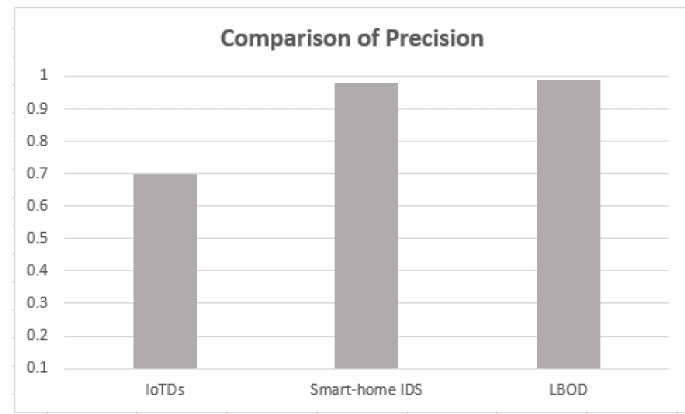
Figure 11. Comparison of precision.